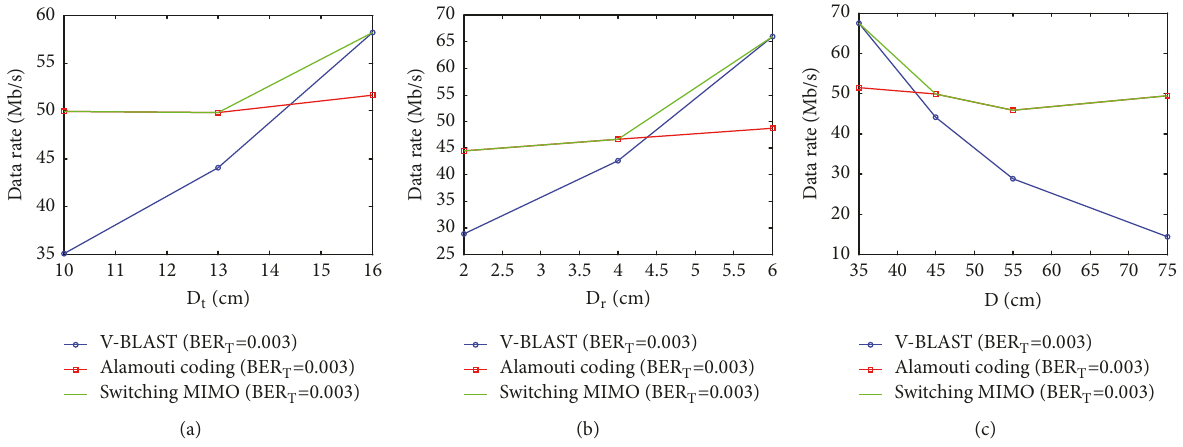
Figure 8: Data rate versus (a) distance between LEDs, (b) distance between PDs, and (c) distance between LED plane and the PD